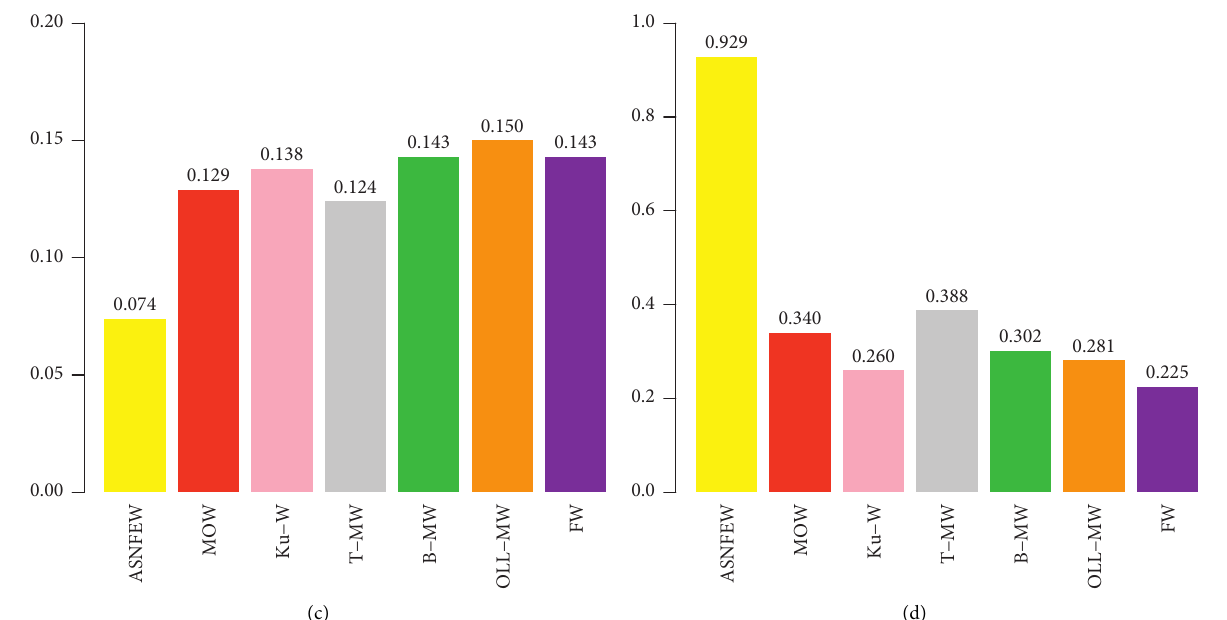
Figure 8: Graphical illustration of the results presented in Table 5. (a) CM, (b) AD, (c) KS, and (d) p value of the fitted models.